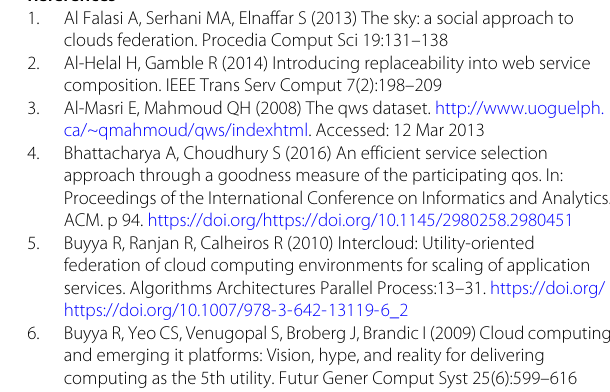
algorithm uses negotiation and replacement algorithm as per need to regain disturbed equilibrium within the ecosystem. Results show that the service ecosystem equi- librium is maintained more successfully for most of the incoming queries compared to recent approaches in [19] and